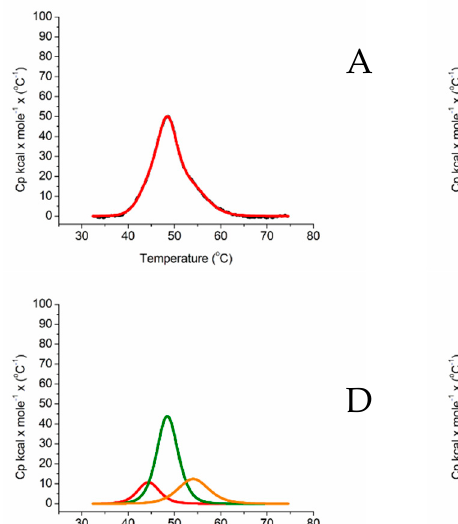
BMR, ( B ) ARO ‐ BMR ‐ 3GLY, ( C ) ARO ‐ BMR ‐ 5GLY. All experiments were carried out at a scan/rate of 90 °C/h. The black lines are the experimental curve of the chimeras, the red lines are the result of the fitting applying a non ‐ two ‐ state denaturation model. Deconvolution of ARO ‐ BMR ( D ), ARO ‐ BMR ‐ 3GLY ( E ), ARO ‐ BMR ‐ 5GLY ( F ). The red lines represent the deconvolution of the denaturation curve of aromatase, the green lines represent the deconvolution of the FAD subdomain from BMR, and the orange lines represent the deconvolution of the FMN subdomain from BMR.